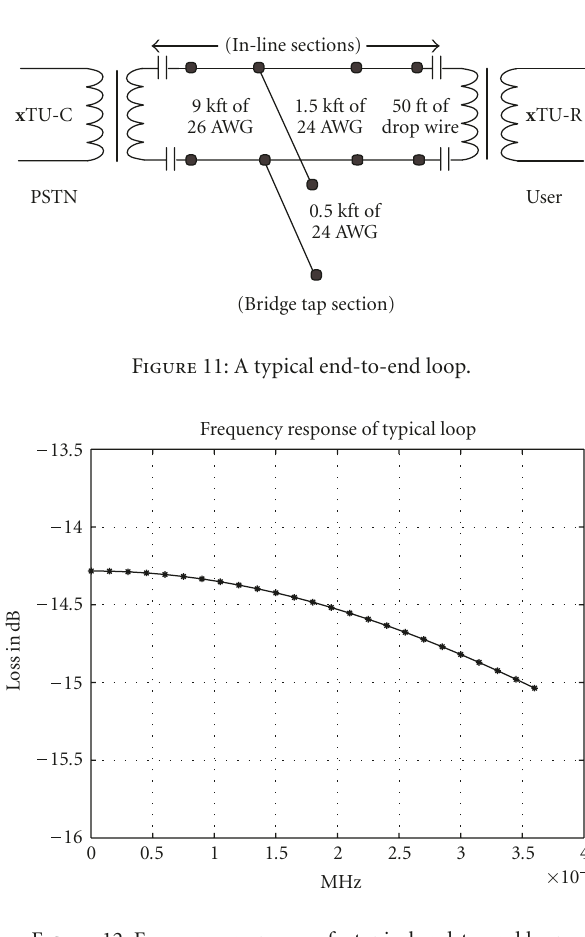
Figure 12: Frequency response of a typical end-to-end